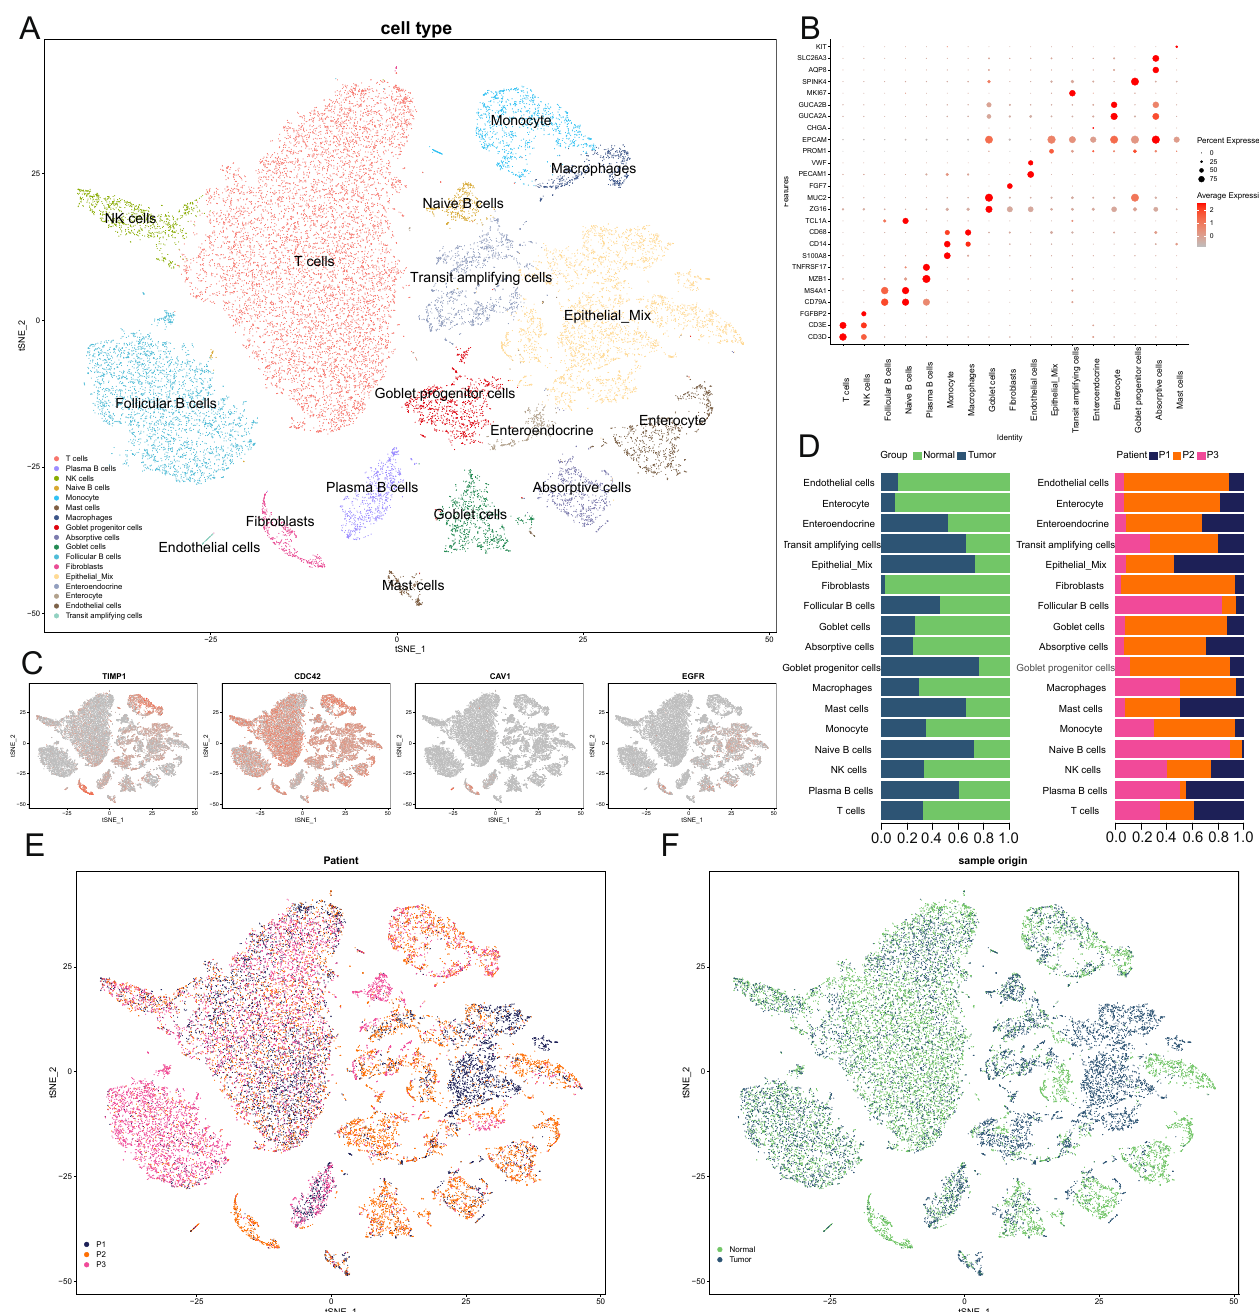
Figure 8. Cell type constitution of the colon normal and adenoma tissues. ( A ) t-SNE plots of cells from three patients (6 samples). Colors represent cell types. Cells were clustered into 17 sub-clusters based on biological annotation. Each dot represents a single cell. ( B ) Dot plot of proportion of cells in the respective cluster expressing selected marker genes. Circle size represents the percentage of cells that express the gene, and color represents the average expression value within a cluster. ( C ) Expression of the 4-MTRGs at the single cell level. ( D ) Bar plot showing the fraction of cells originating from the 3 normal and 3 tumor samples (left) and the fraction of cells originating from each of the 3 patients (right). ( E , F ) t-SNE plots of patient origin ( E ) and sample origin ( F